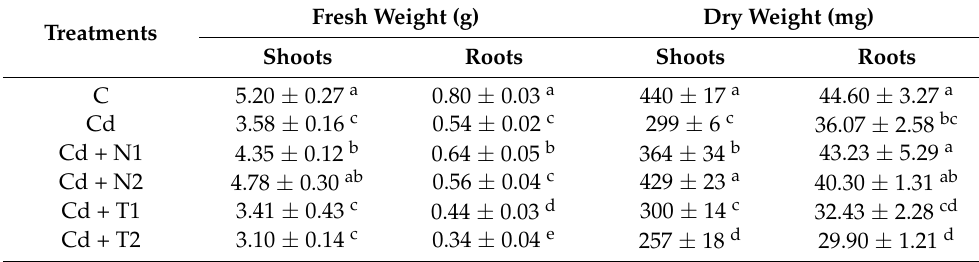
Table 2. Fresh and dry weight of tomato plants under Cd stress.